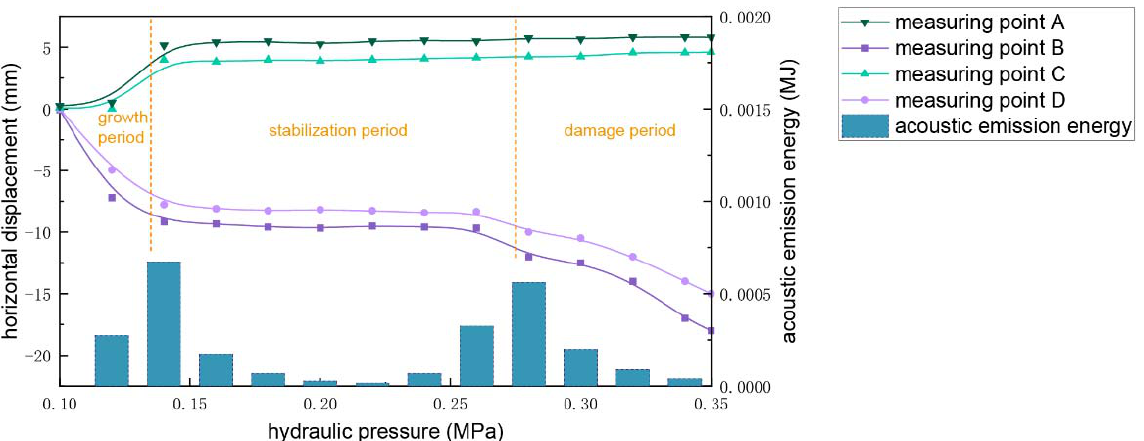
Figure 23. The relationship between the acoustic emission energy and the convergence deformation of the measurement point with the water pressure of the karst cave for model 1.